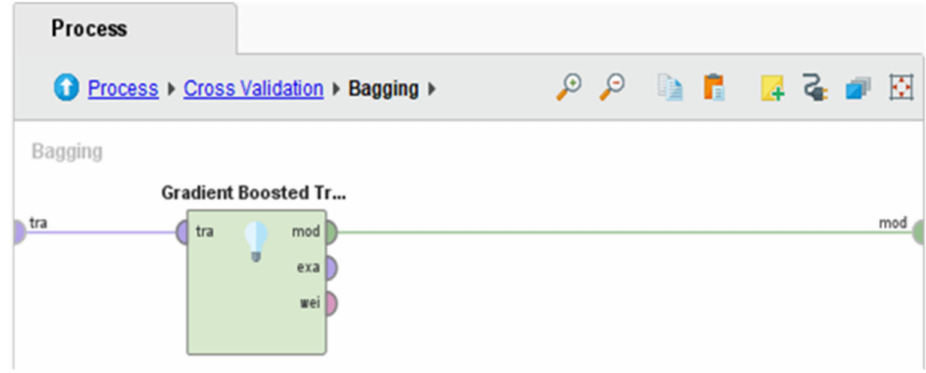
Figure 5. Inside view of bagging (step 2).